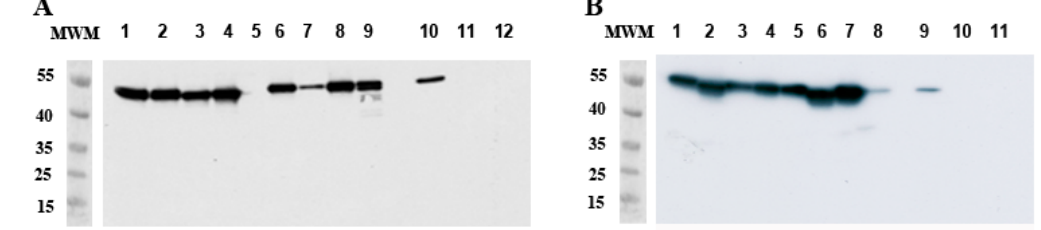
Figure 3. Detection of ZIKV E protein by Western blot in Ae. aegypti and Ae. albopictus SG at 14 dpi. ( A ) Lines 1 to 9: Ae. aegypti SG infected by ZIKV; ( B ) Lines 1 to 8 Ae. albopictus SG infected by ZIKV. Controls are shown in each figure and consist of ZIKV-infected Vero cell lysate (positive control, lines 10A and 9B), L15 medium (lines 11A and 10B), and non-infected MG (lines 12A and 11B). MWM: molecular weight markers are indicated in kDa.